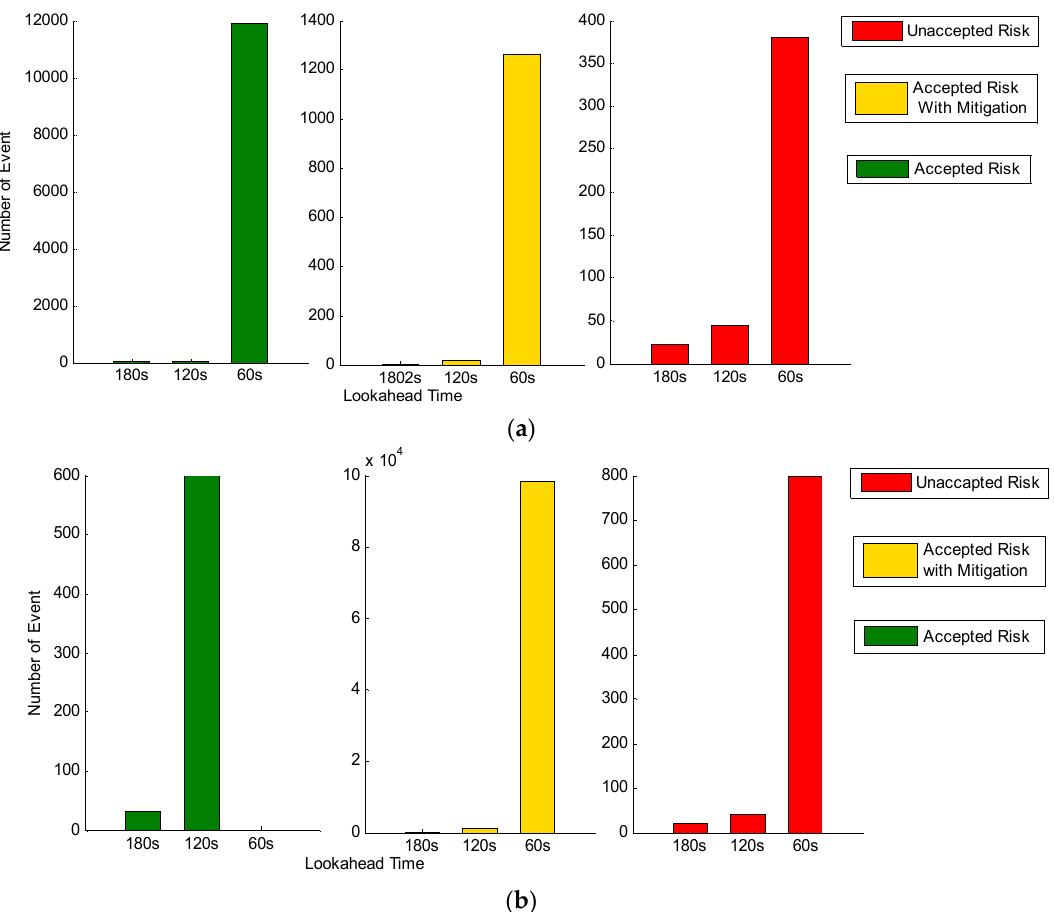
Figure 6. Change in risk with different look-ahead time, ( a ) head-to-head encounter; ( b ) overtaking encounter. Each figure illustrates the number of alerts affected by drop-out of 10 5 simulation for different look-ahead time. Different vertical axis is utilized to outline how the magnitude of the order increased with different look-ahead time. The bar charts imply that the alerts are mostly affected by a smaller look-ahead window. Also, it depicts that even though the number of alerts increases with smaller look-ahead window, the unacceptable risk events are minimal.